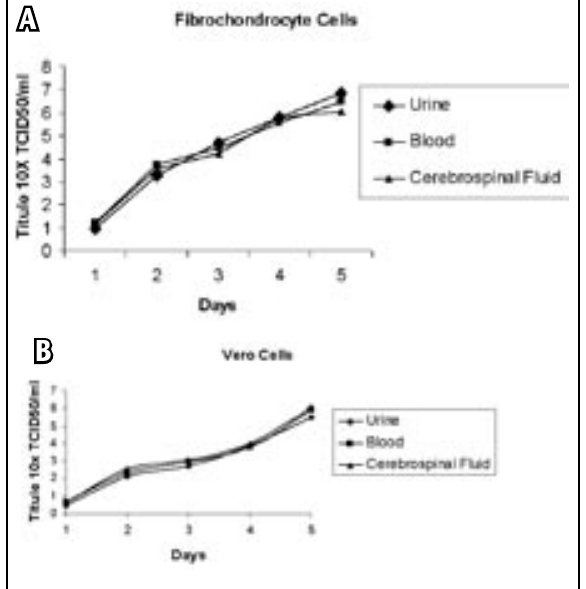
Figure 2 – A: Curve of the increased infectivity of fibrochondrocyte cells infected with samples (urine, blood and cerebrospinal fluid) and observed during 5 days; B: Vero cells infected with the same